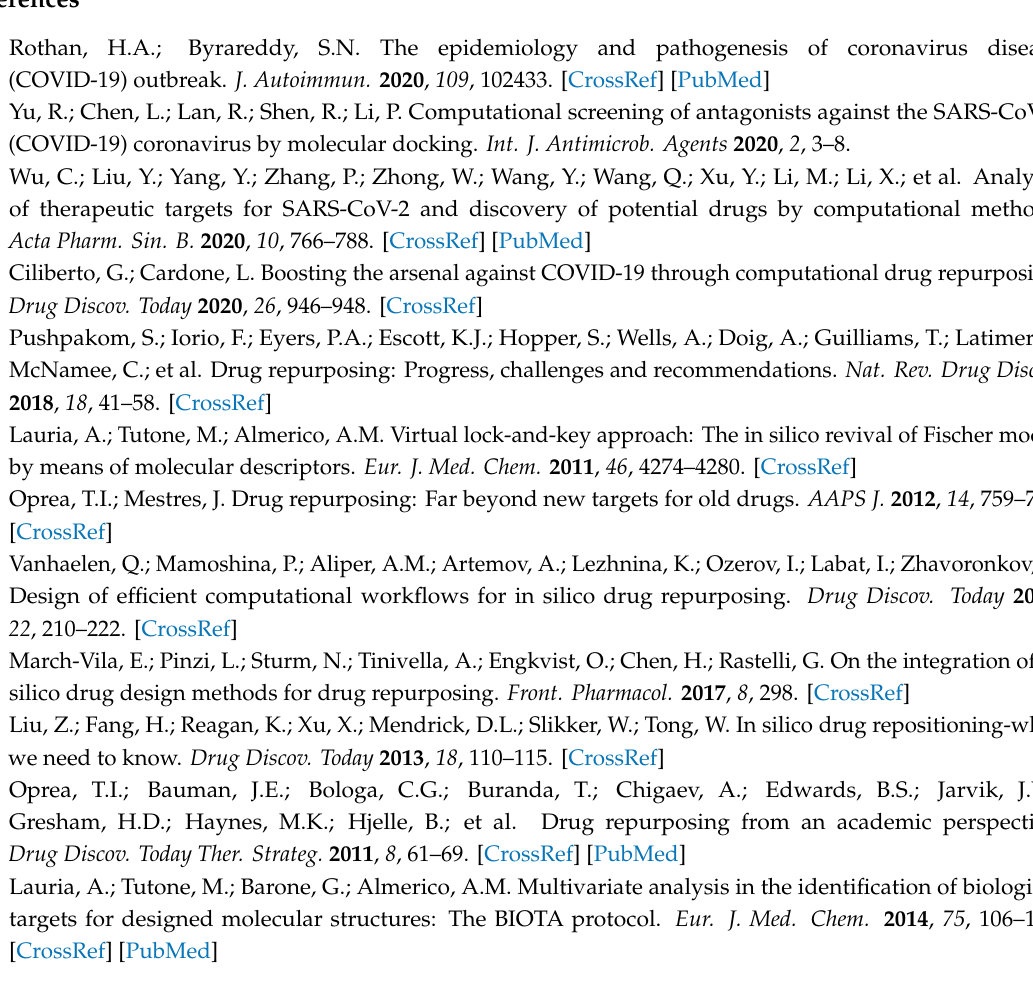
Table S1: Docking scores, ∆ Gbinding and protein-ligand interactions of 36 inhibitors; Figure S1: Ligand interaction diagram of the (a) DB08239 binding pose in 3C-like Protease; (b) DB07358 binding pose in Papain-like Protease; (c) DB02933 binding pose in nsp14; Figure S2: Ligand interaction diagram of the (a) DB1792 binding pose in nsp15; (b) DB01859 binding pose in nsp16; Figure S3: Ligand interaction diagram of the (a) Synapoyl Coenzyme A binding pose in nsp4; (b) the DB02794 binding pose in nsp9; Figure S4: Ligand interaction diagram of the (a) DB04579 binding pose in helicase, pocket A; (b) PCI-27483 binding pocket in helicase, pocket B; Figure S5: Ligand interaction diagram of the (a) Flavin-N7 Protonated-Adenine Dinucleotide binding pose in nsp7-8, pocket A; (b) DB06955 binding pocket in nsp7-8, pocket B; Figure S6: Ligand interaction diagram of the (a) DB04579 binding pose in nsp7-8-12, pocket A; (b) PCI-27483 in nsp7-8-12, pocket